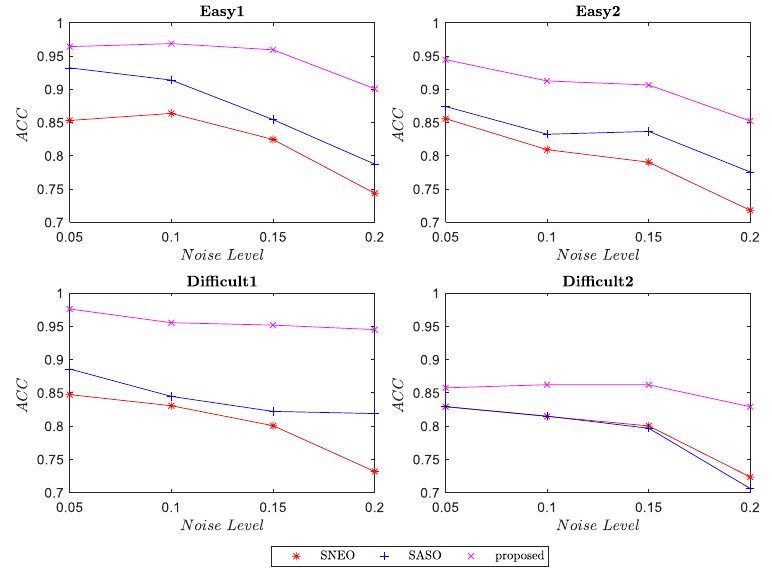
Figure 6. Accuracy results of energy operators on four synthetic datasets over four different noise levels: SNEO , SASO , and our proposal. The smoothed versions were considered with a tuning parameter of 4 and a Hamming window of length